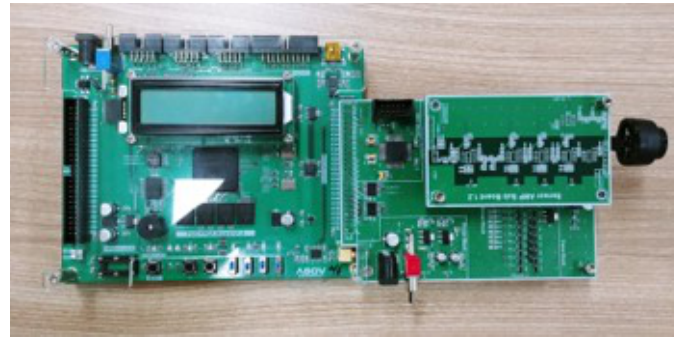
Figure 7. Implemented ultrasonic modem.